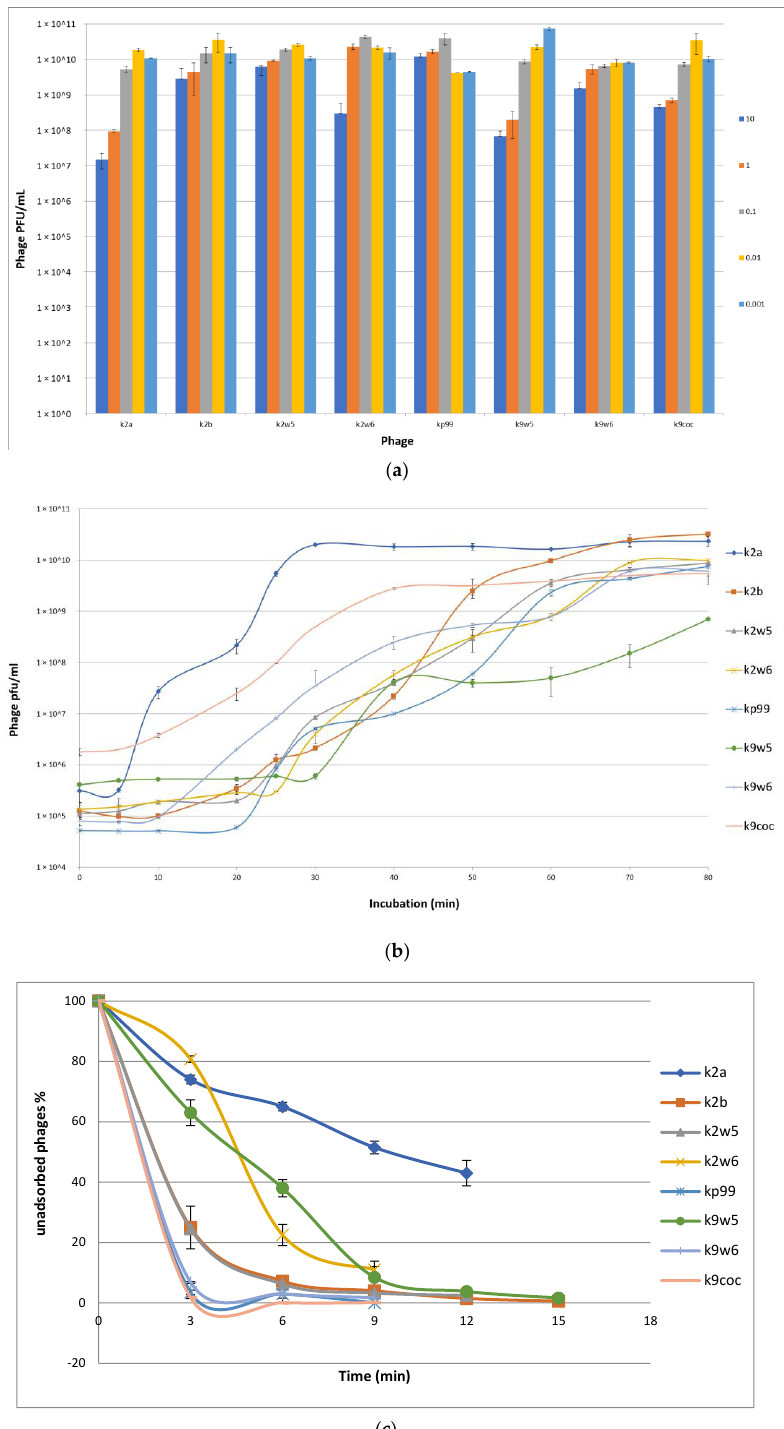
Figure 3. ( a ) Optimal multiplicity of infection (MOI) of bacteriophages. Comparisons of bacteriophage titers after incubation for 6 h at six different MOI (0.001, 0.01, 0.1,1 and 10 PFU/CFU); ( b ) The one-step growth curves of bacteriophages. The bacterial culture was mixed with the bacteriophage suspension to obtain MOI 0.01. Bacteriophages were allowed to adsorb for 10 min at 37 °C. Triplicate samples were taken every 10 min for 80 min and titrated. All data were collected from three independent experiments, error bars indicate the standard deviation; ( c ) The adsorption rate of the bacteriophages. Bacteriophages were mixed with excess K. pneumoniae KP2 cells, and the non-adsorbed infectious bacteriophages were serially counted. The data show percentages of un-adsorbed bacteriophages relative to the initial input dose of bacteriophages.